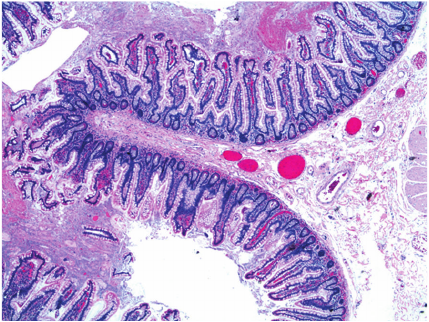
Figure4:LowpowerviewoftheMeckel’sdiverticulum.Histological review did not reveal any aberrant tissue